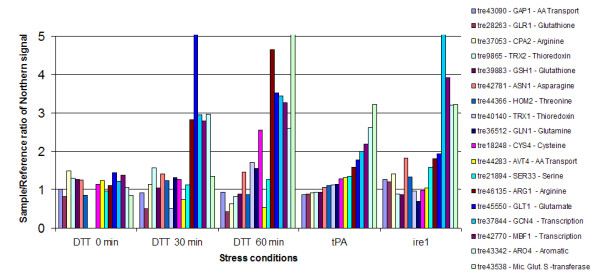
Northern analysis of genes related to amino acid biosynthesis and glutathione metabolism in T. reesei. The expression level of the genes was analysed in bioreactor cultures treated with DTT for 0, 30 and 60 min and in untreated reference cultures, in chemostat cultures of a tPA producing strain and its parental strain, and in a strain overexpressing ire1 and in its parental strain. The signals of the specific mRNAs were quantified and normalised using the signals of gpd1. The ratio of the signal in the analysed sample vs. the signal in a corresponding reference culture are shown. T. reesei protein model identifier (genome version 1.2), likely S. cerevisiae homologue and amino acid for whose biosynthesis or use the gene is involved is indicated after the gene name. DTT 0 min, DTT treatment 0 min; DTT 30 min, DTT treatment 30 min; DTT 60 min, DTT treatment for 60 min; tPA, tPA producing chemostat culture; ire1, ire1 overexpressing strain, AA transport, amino acid transport.